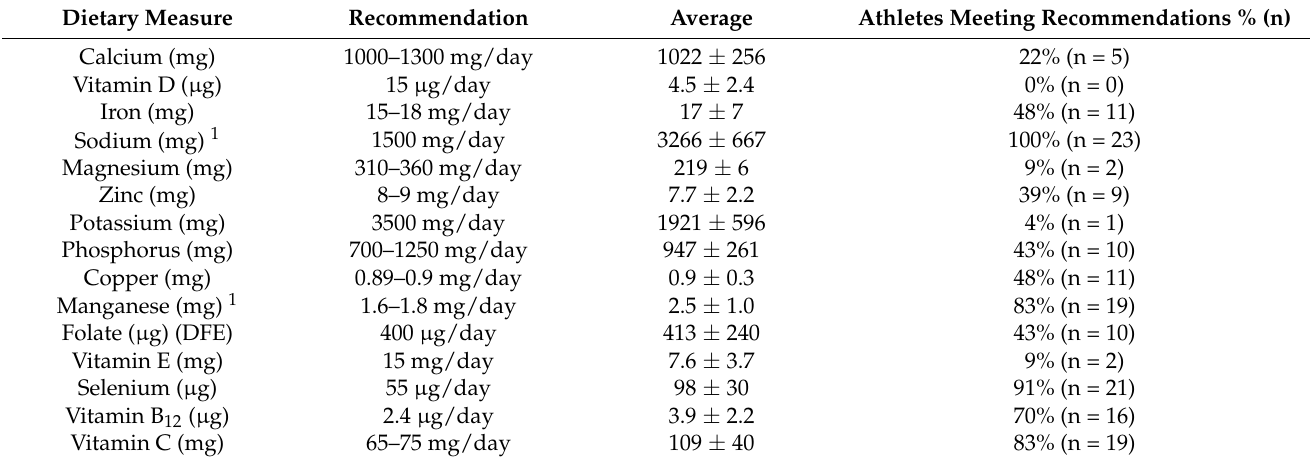
Table 3. Average 7-day micronutrient intakes for female ice hockey players, and percent of athletes meeting recommended micronutrient